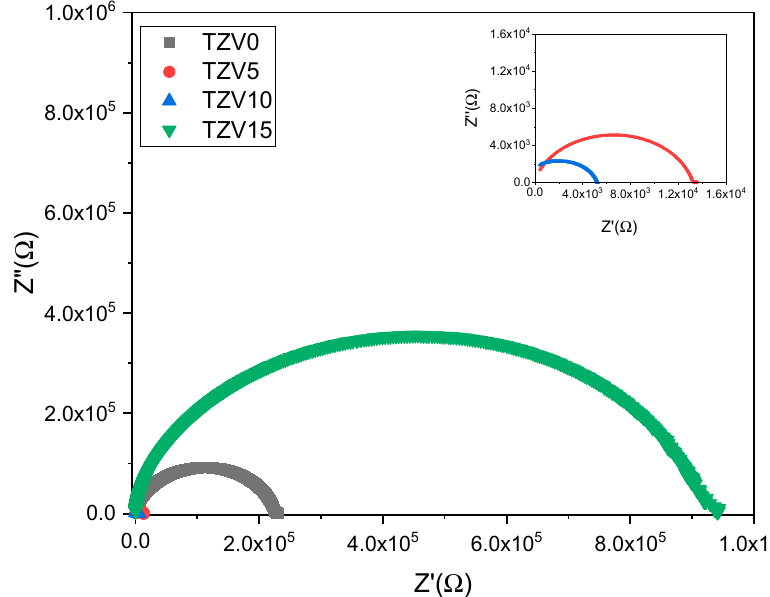
Figure 5. Cole–Cole plot of the TZV glass samples at 340 ◦